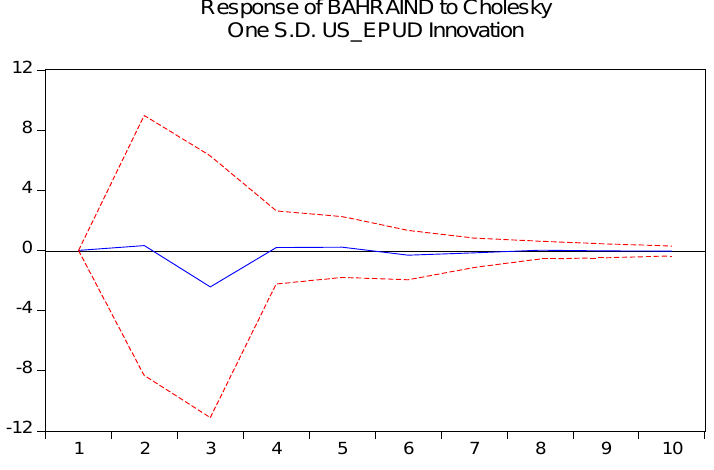
Fig. 1. The impulse response functions of the returns on Bahrain stock market to changes in the U.S. economic policy uncertainty (2004:M7 –